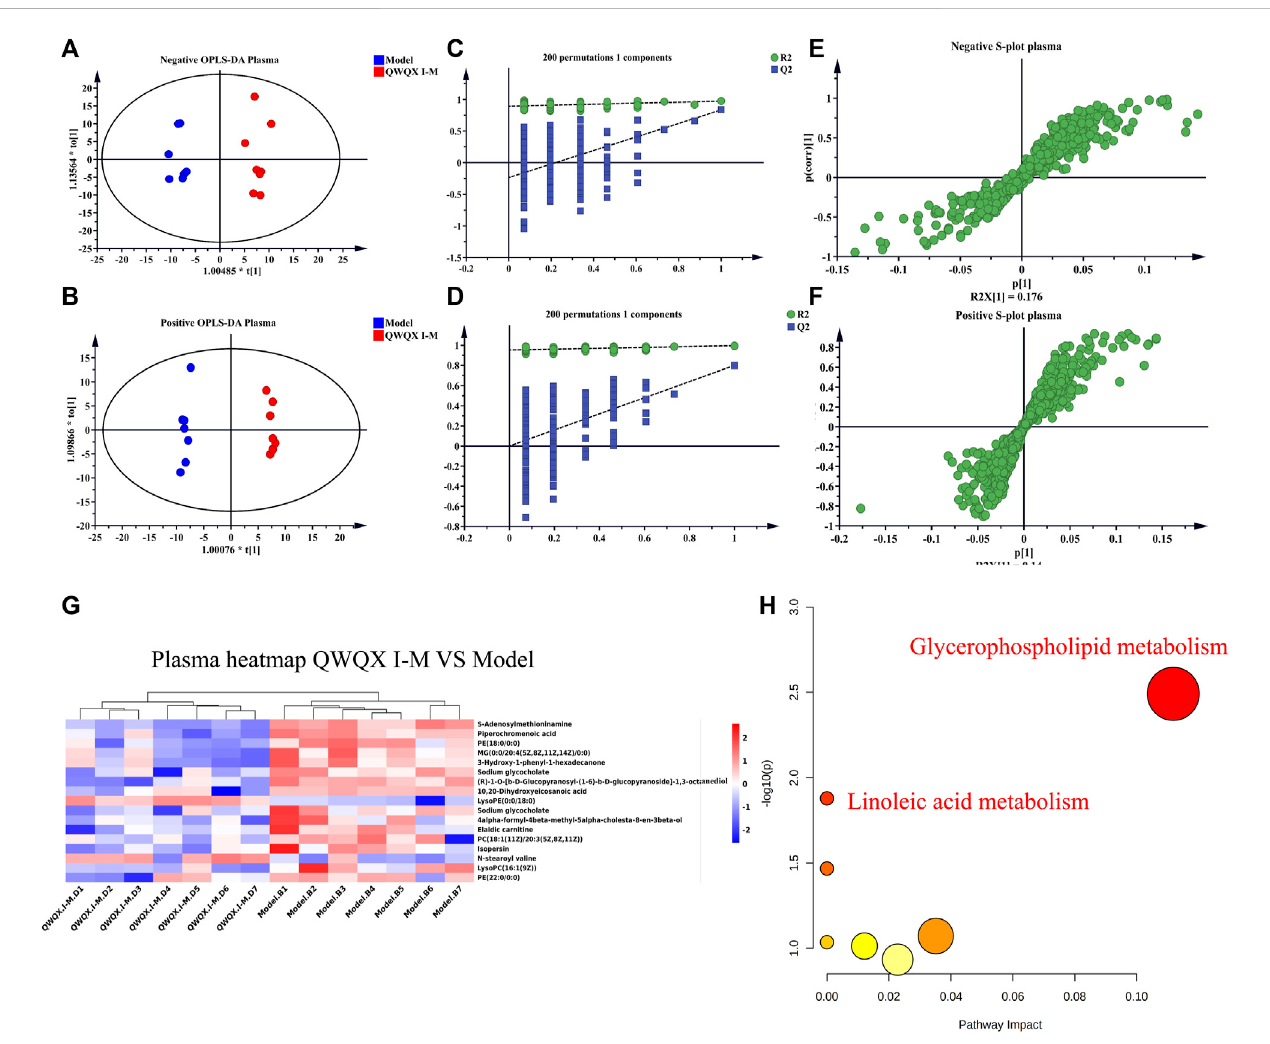
FIGURE 6 Multivariate statistical analysis of plasma in QWQX I and the model groups of rats. (A – B) Plots of OPLS-DA scores in QWQX I and model groups. (C – D) Validation plots after 200 replacement tests. (E – F) S-plots of QWQX I and model groups in OPLS-DA model. (G) Heatmap of QWQX I against chronic heart failure in rats. (H) Plots of metabolic pathways associated with QWQX I against chronic heart failure in rats. (A, C, E) negative mode; (B, D, F) positive